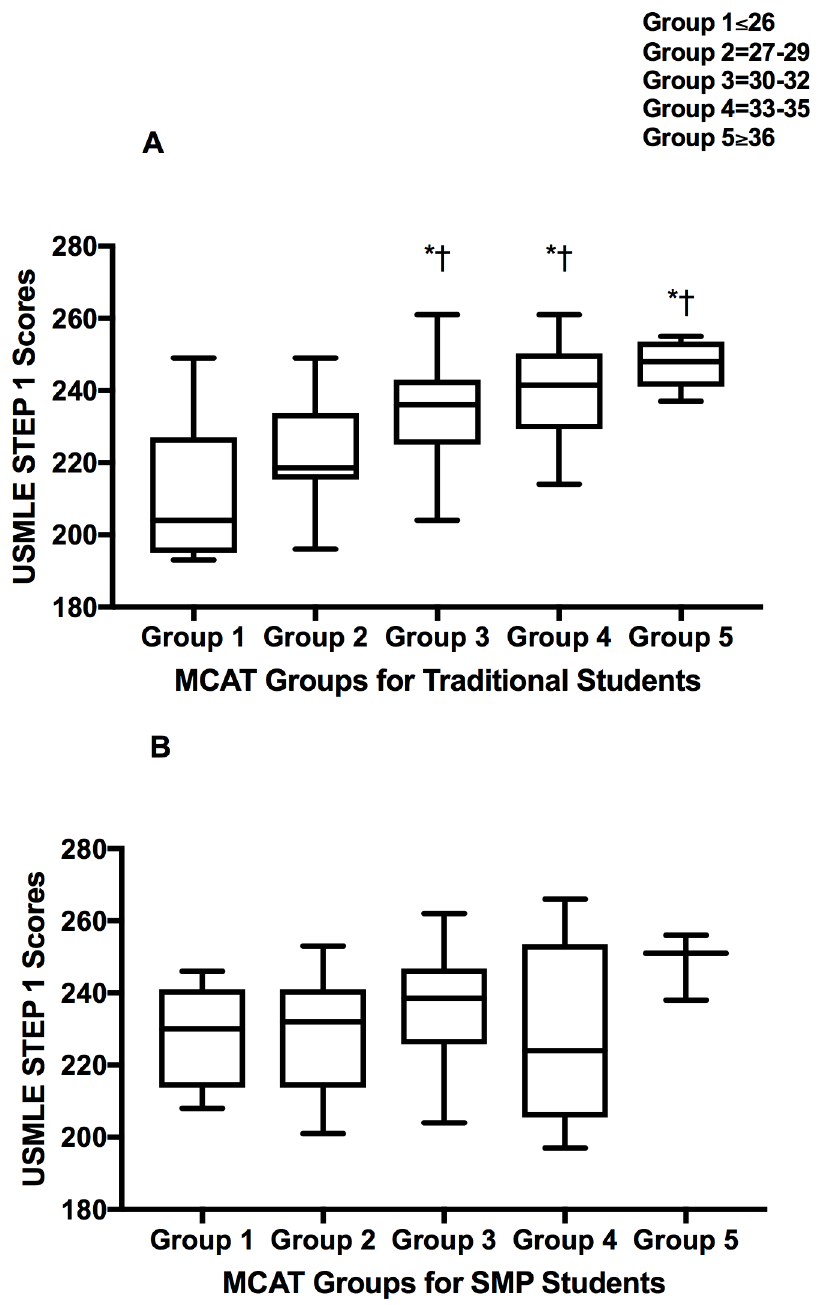
Fig 2. USMLE STEP 1 Scores Based on MCAT Groupings for Traditional (A) Students and SMP- students (B). Students were categorized into 5 groupsbased on MCAT scores (Group 1 = 26 and below; Group 2 = 27–29; Group 3 = 30–32;Group 4 = 33–35; Group 5 = 36 and above) and then further dividedinto SMP and Traditionalstudents and comparative analysiswas performed using One-way ANOVA with Tukey Kramer Post-hoc analysis. * = p < 0.05vs. traditionalgroup 1; † = p < 0.05vs. traditionalgroup 2.